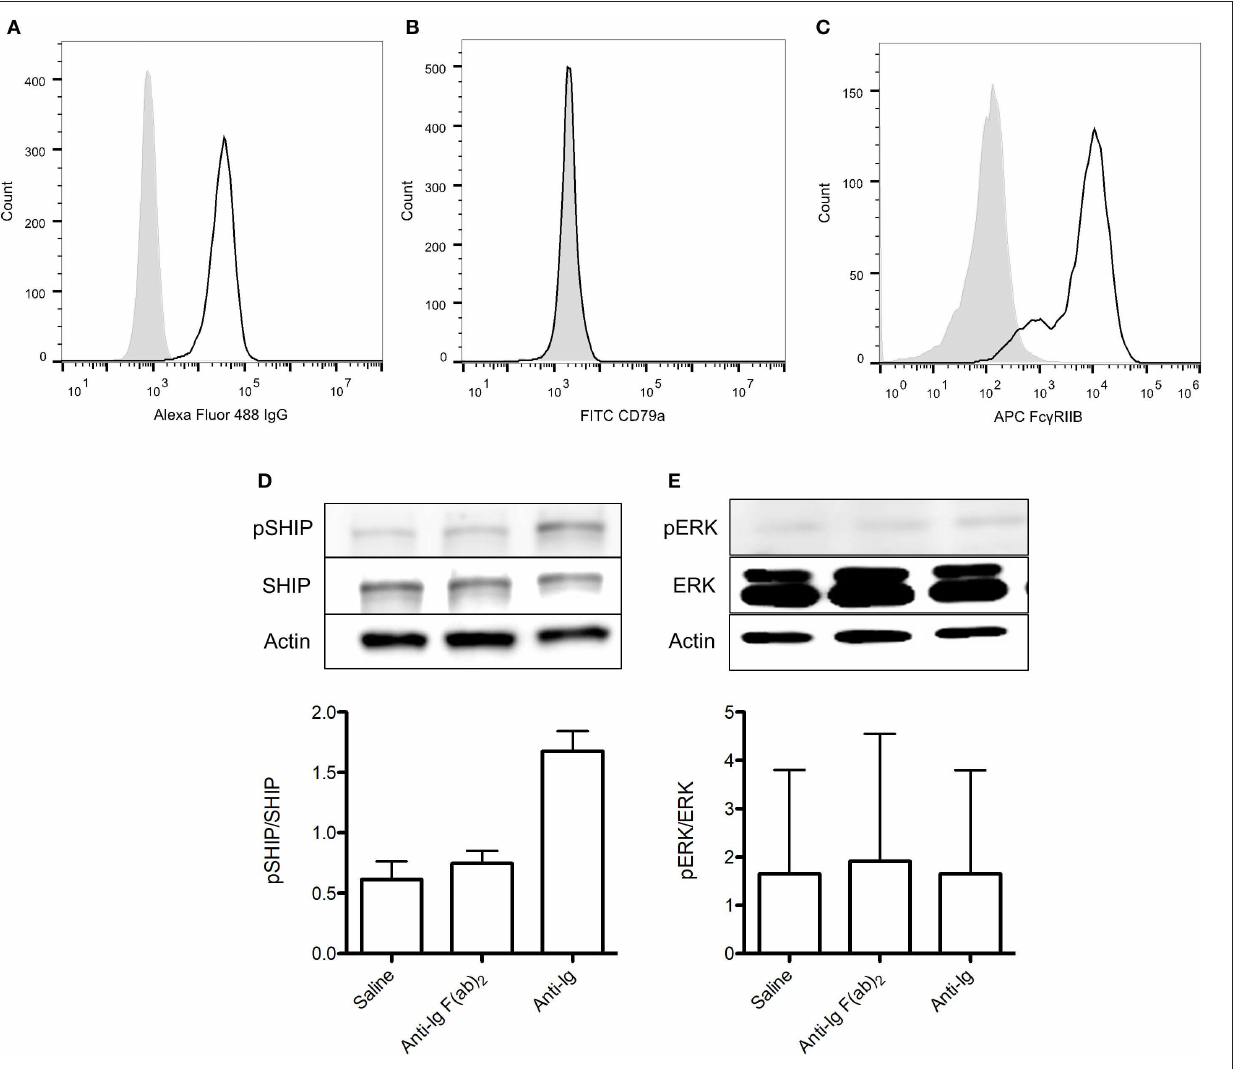
FIGURE 6 | 413 cells are an appropriate model for assessing rFVIIIFc binding and Fc γ RIIB signaling. (A) IgG, (B) CD79a, and (C) Fc γ RIIB expression of 413 cells. (D) pSHIP and (E) pERK levels in 413 cells stimulated with saline, anti-Ig F(ab) 2 (20 µ g/ml) and anti-Ig (20 µ g/ml). Ratios of phosphorylated SHIP to total SHIP were obtained through densitometry analysis of three different blots. n = 3/condition. Error bars represent SD. , control isotype antibody; , antibody of